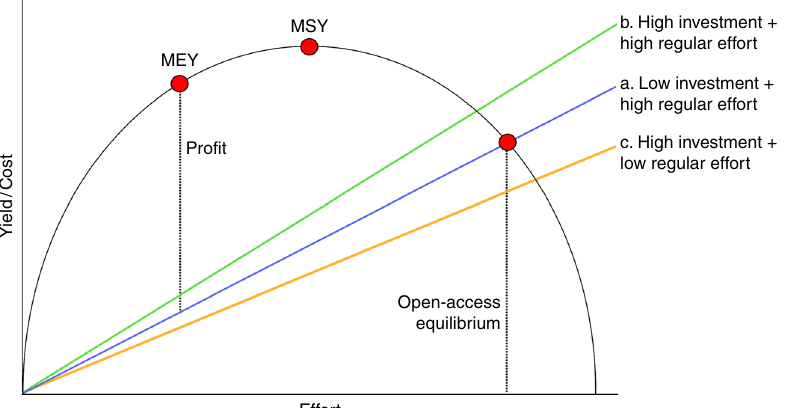
Fig. 5 The Gordon-Schaefer fi xed price bioeconomic model 75 indicating the open-access equilibrium where cost equals the effort – yield curve. Also shown are theoretical variations of this relationship based on differing levels of initial investment and regular effort. The high-investment – low-effort nature of fi sh fences could exacerbate over fi shing by removing some traditional bioeconomic